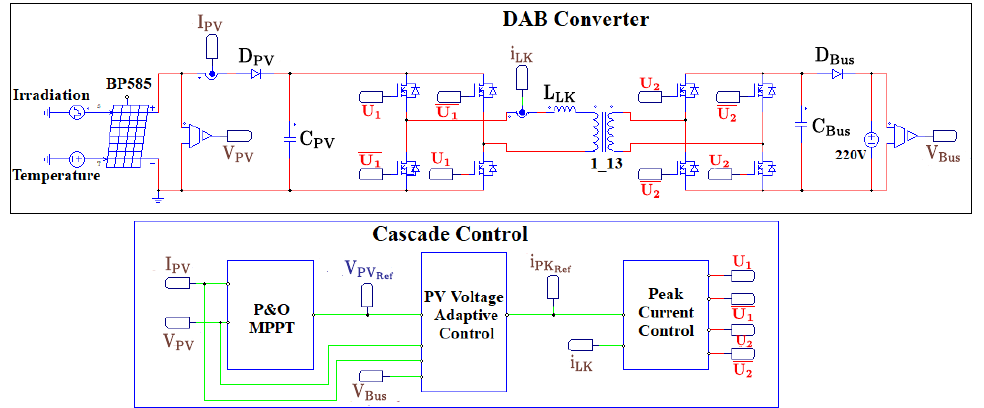
Figure 11. PV system based on a DAB converter implemented in PSIM.